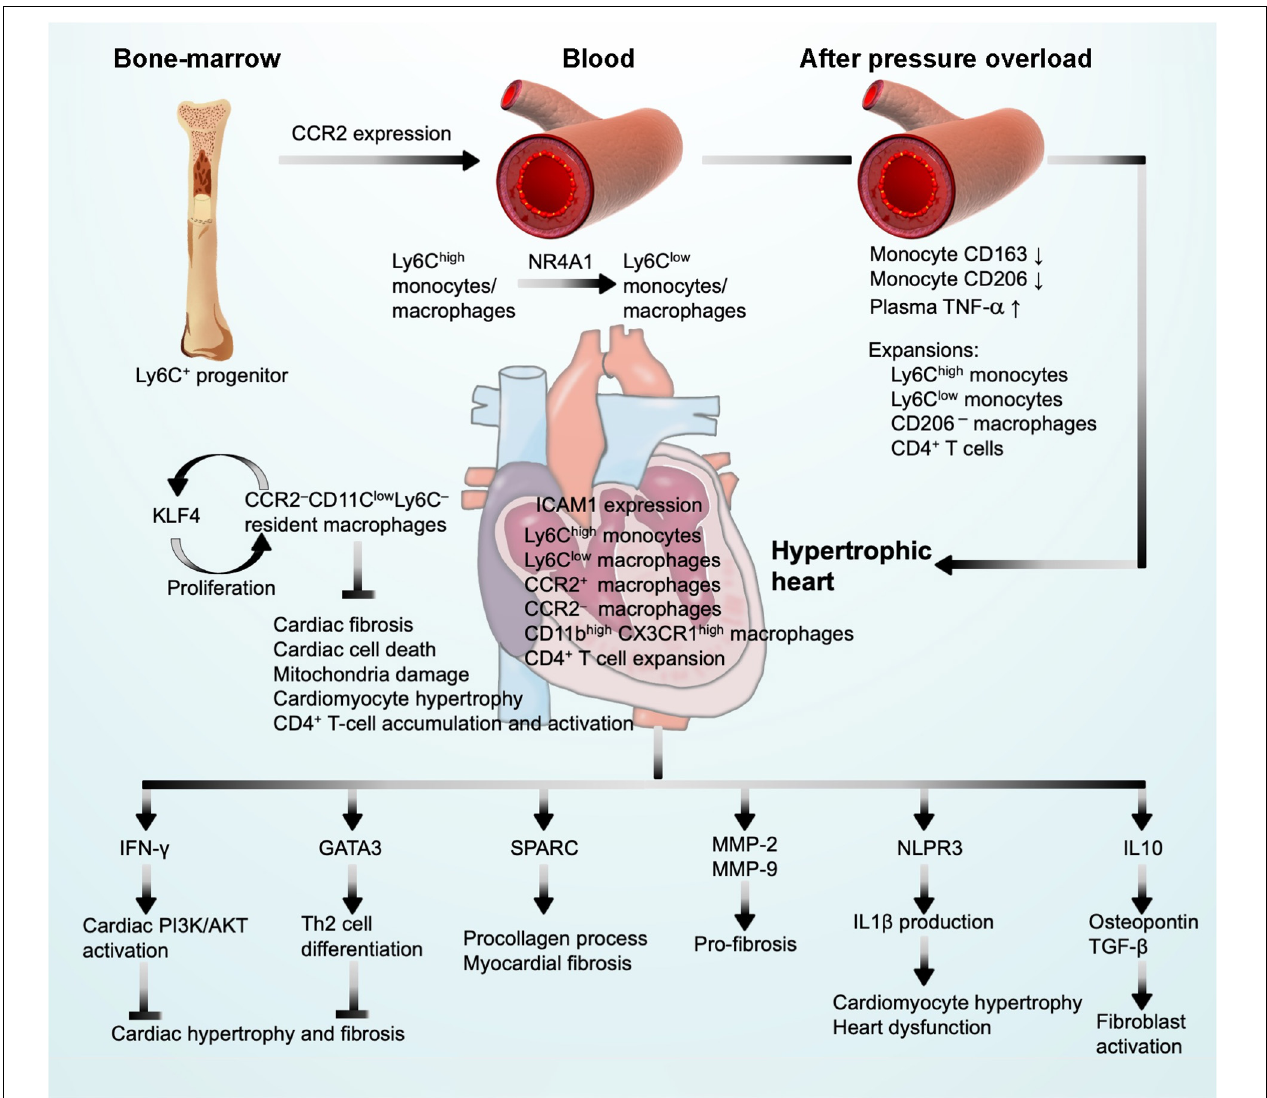
FIGURE 3 | Monocyte and macrophage function in pressure overload-induced cardiac hypertrophy and fibrosis. CCR2 expression drives Ly6C + monocyte progenitor trafficking to peripheral blood where monocyte differentiation may occur. After pressure overload injury, blood monocytes undergo phenotypic alterations and monocyte/macrophage expansion. These cells infiltrate into the heart where they produce IFN- γ and GATA3 to block cardiac hypertrophy and fibrosis, produce SPARC, MMP-2, MMP-9, IL1 β , and IL10 to promote cardiac hypertrophy and cardiac fibrosis, leading to cardiac dysfunction, and express KLF4 to promote macrophage